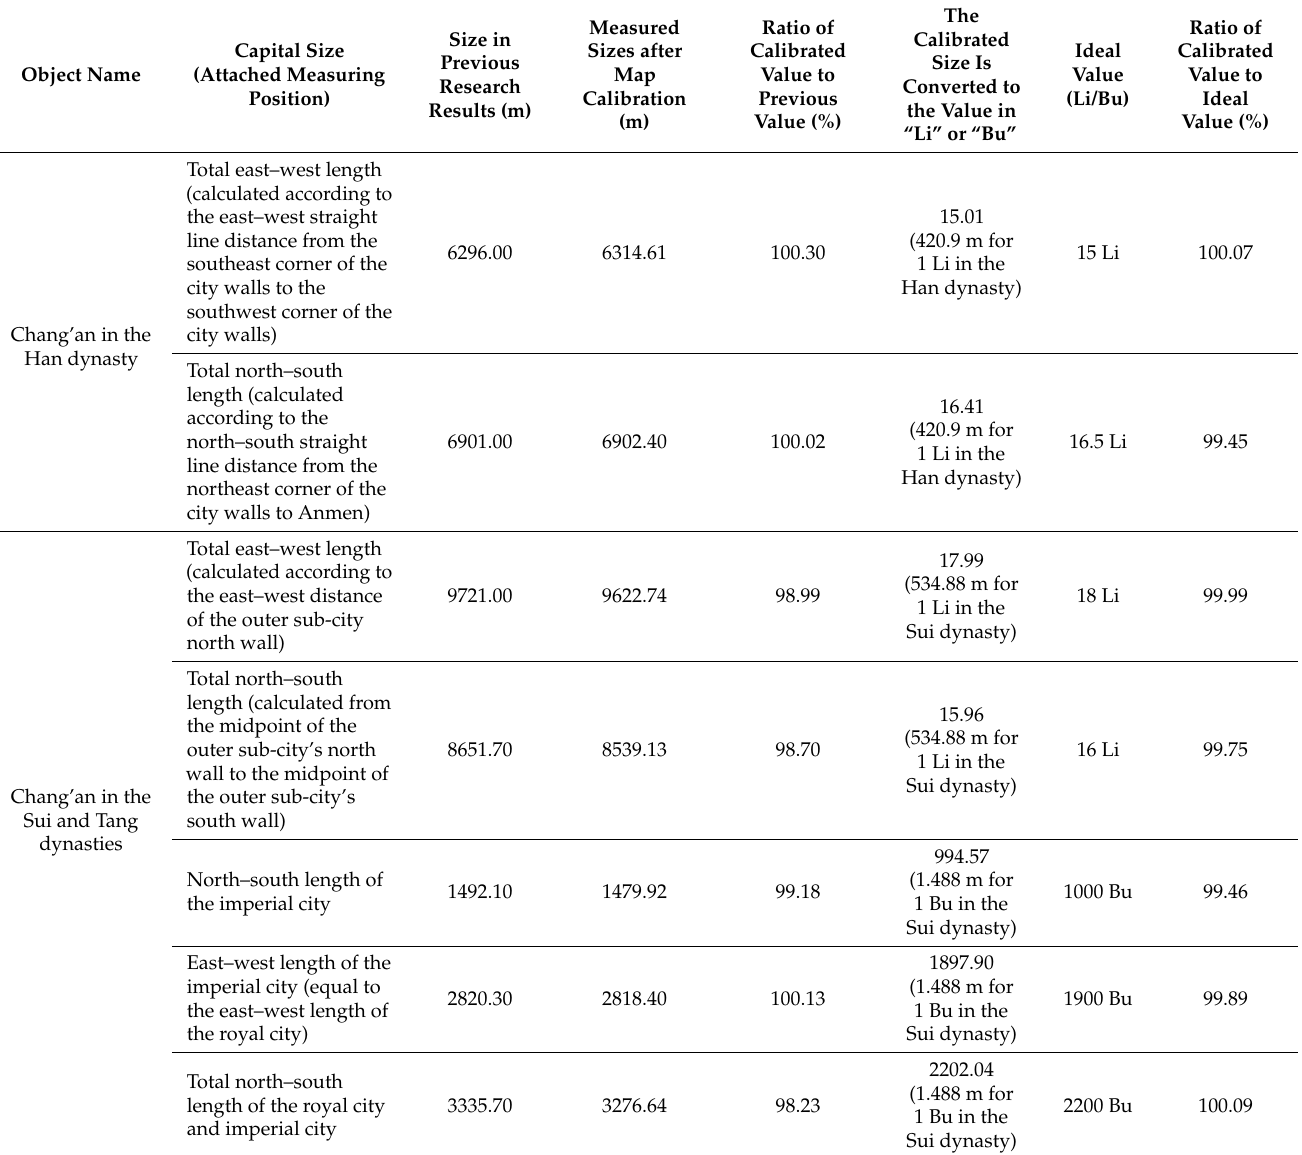
Table 2. Size and ideal value analysis table of Chinese capitals of the Western Han dynasty as well as the Sui and Tang